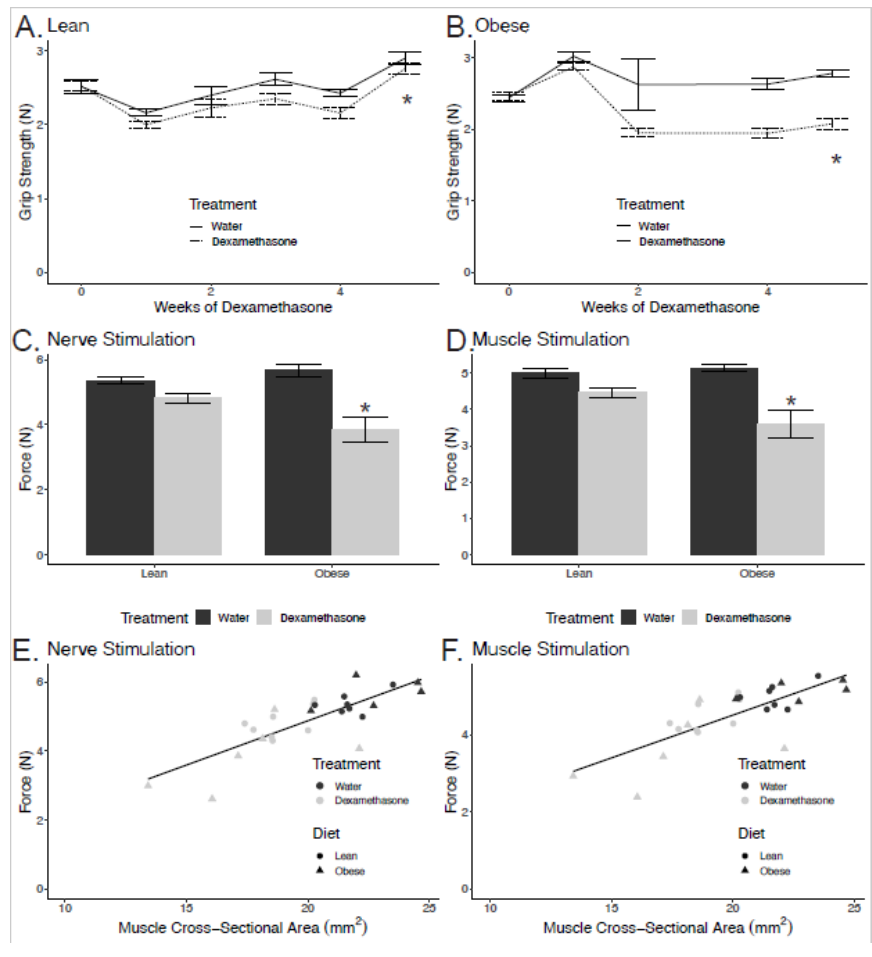
Figure 1. Obese dexamethasone-treated mice have reduced muscle strength. Grip strength in lean ( A ) and obese ( B ) male mice over five weeks of dexamethasone treatment (n = 4–8 per group). Mice were fed a high fat diet (HFD) or normal chow diet (NCD) for 12 weeks prior to randomization into water or dexamethasone treatments. Force generated by nerve stimulation ( C ) and direct muscle stimulation ( D ) of the gastrocnemius muscle in lean and obese mice treated with vehicle (water) or dexamethasone for 15–21 days after 12 weeks of NCD or HFD. Force plotted relative to whole muscle cross-sectional area (CSA) ( E , F ). Asterisks indicate significant interaction between diet and treatment by two-way ANOVA, except for panels ( A ) and ( B ), where they indicate a difference between treatments (n = 5–8 per group).